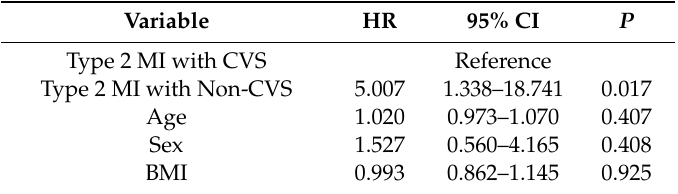
Table 5. Cox hazards model analysis in the type 2 MI adjusting for age, sex, and